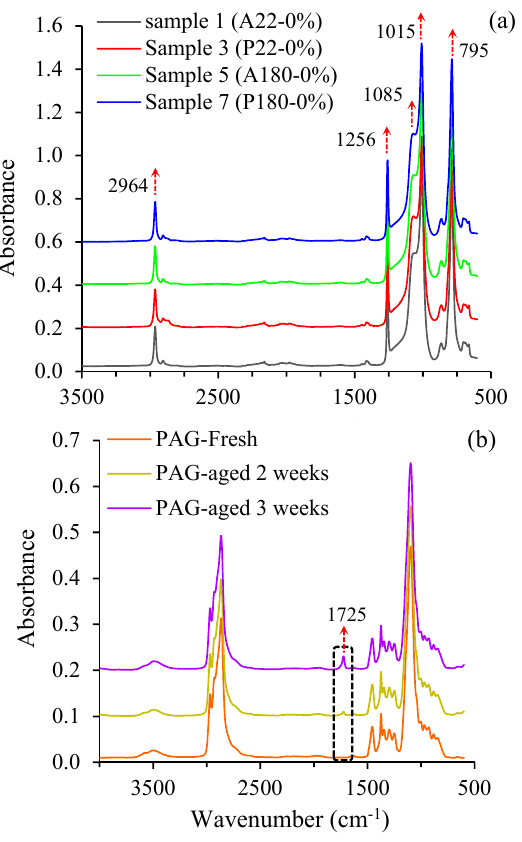
Figure 7. FTIR spectra of ( a ) SR samples and ( b ) PAG samples.